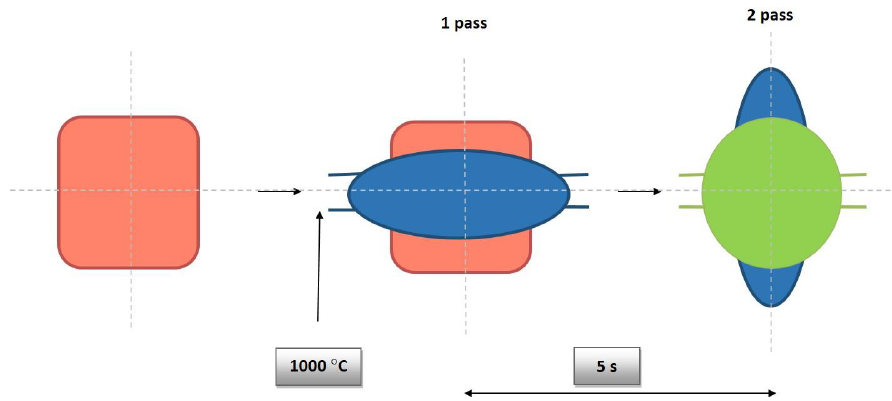
Figure 23. Modeling scheme of the shape rolling.